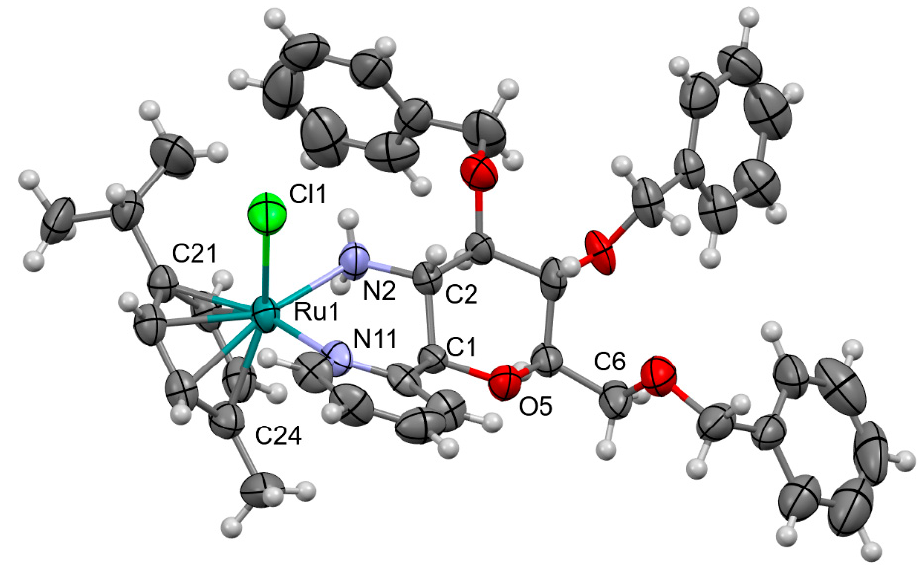
Figure 2. ORTEP view of Ru-3a at a 50% probability level with a partial numbering scheme. The PF 6 − counter ion is omitted for clarity. Selected bond distance (Å) and bond length ( o ) data: Ru(1)-N(2) 2.153(13), Ru(1)-N(11) 2.091(14), Ru(1)-Cl(1) 2.374(5), Ru(1)-C Ar (avg) 2.180(16), C(1)-C(2) 1.536(19), N(11)-Ru(1)-N(2) 87.3(5), N(11)-Ru(1)-Cl(1) 85.0(4), N(2)-Ru(1)-Cl(1) 82.4(4). For further details, see the Supplementary Materials.